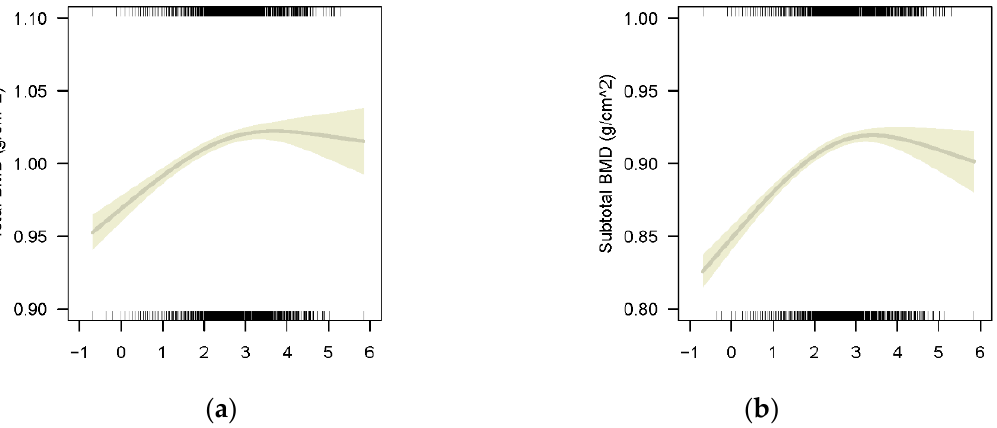
Figure 2. Multivariate models for ln-transformed BLLs on total BMD and subtotal BMD adjusted for age, sex, race/ethnicity, height, weight, family-income-to-poverty ratio and blood cadmium, with results weighted for sampling strategy: ( a ) Total BMD, F = 50.73, p < 0.001, R-sq.(adj) = 0.755; ( b ) Subtotal BMD, F = 124.2, p = <0.001, R-sq.(adj) = 0.799.